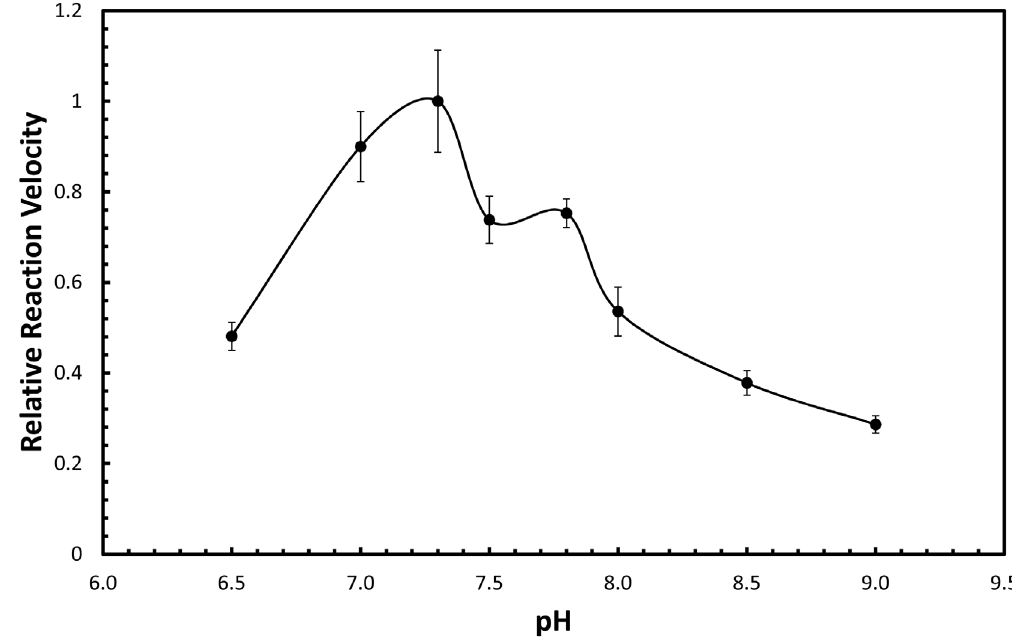
Figure 1. pH dependence of S.cerevisiae phosphomevalonate kinase.